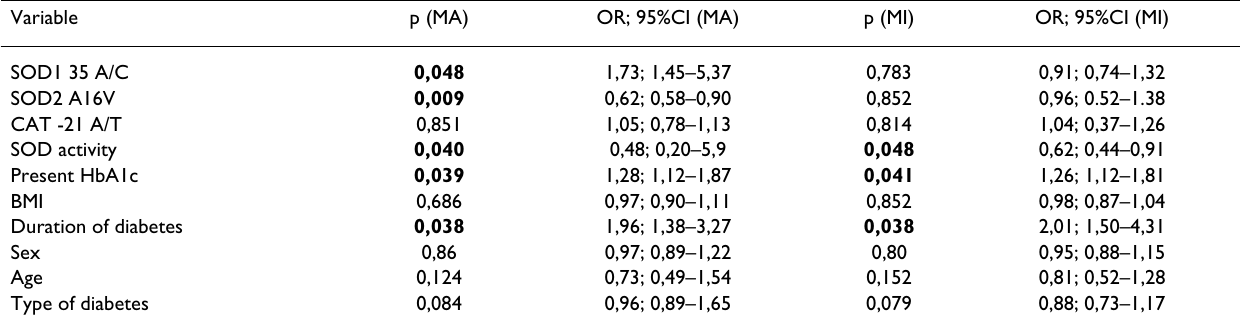
Table 5: Logistic regression analysis for risk factors of the vascular complications in diabetes mellitus.